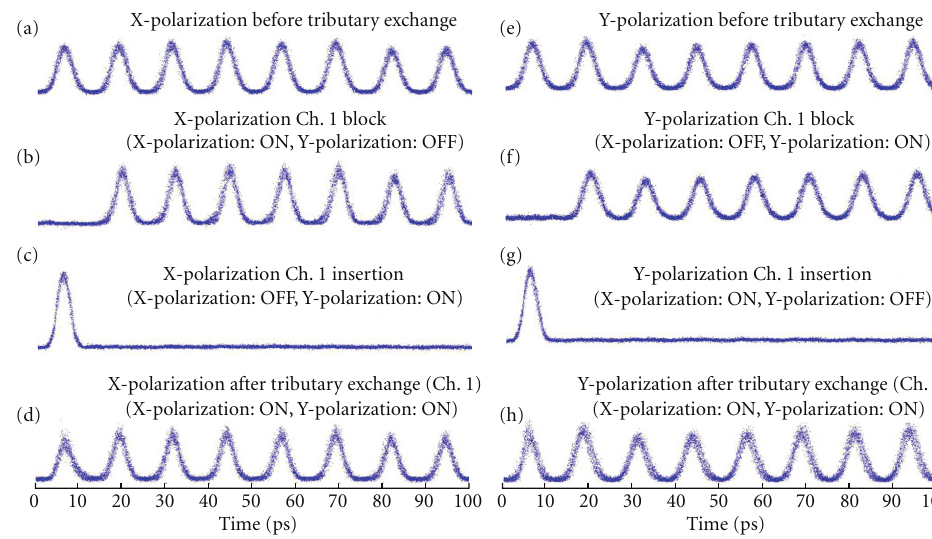
Figure 31: Eye diagrams of orthogonal tributary channel (Ch.1) exchange of a 160Gbit/s pol-muxed DPSK OTDM signal.